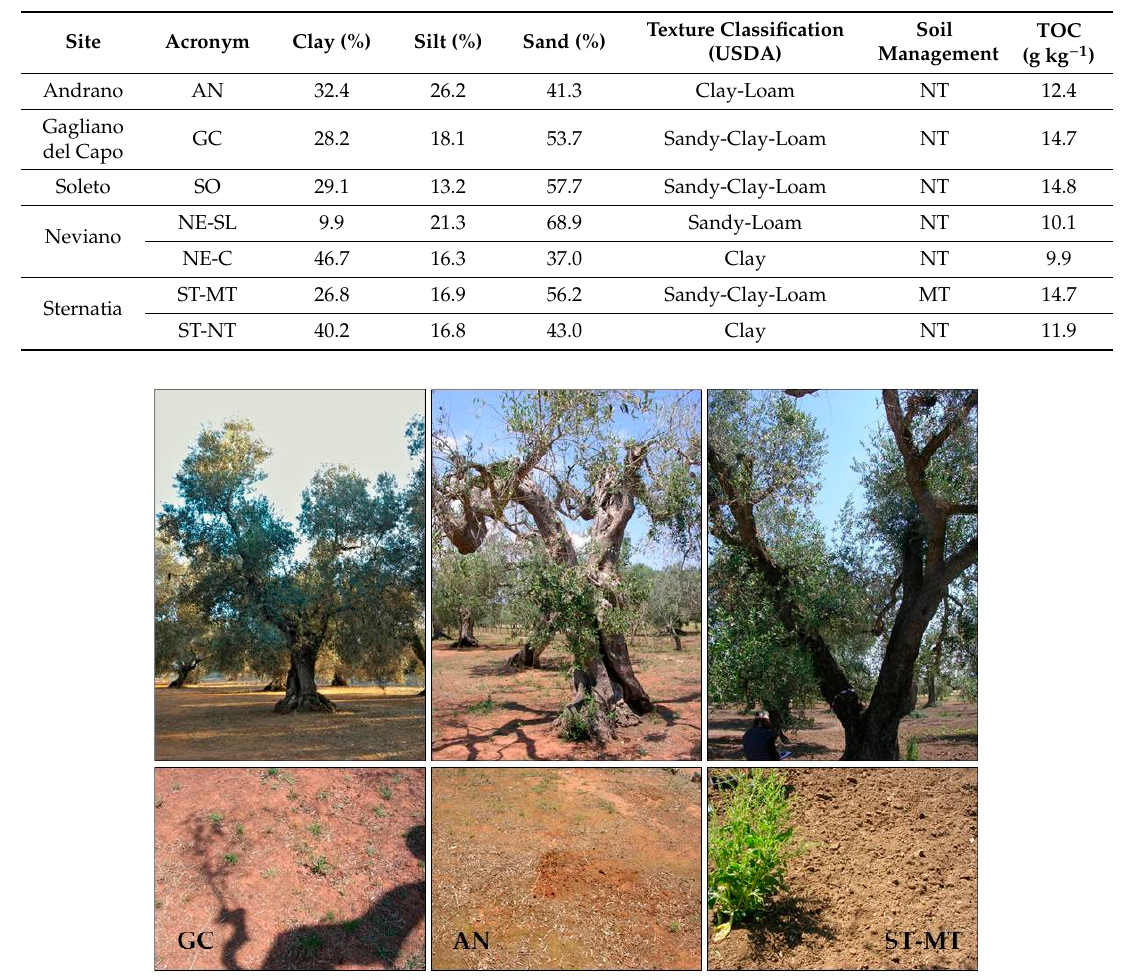
Figure 1. Images of Gagliano del Capo (GC), Andrano (AN), and Sternatia-MT (ST-MT) sites and corresponding soil tillage conditions (i.e., NT or MT, respectively GC, AN, or ST-MT) at the time of infiltration measurements.